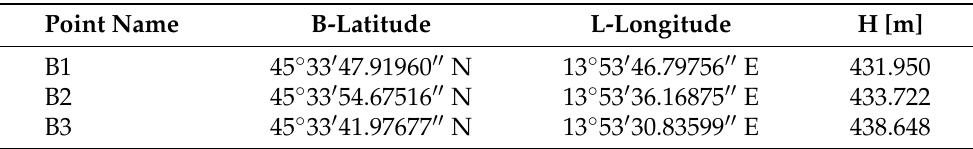
Table 3. Locations in the ETRS89 coordinate system of three base receivers. Heights (H) were acquired from the ellipsoidal heights by using the SLOVRP2016/Koper geoid